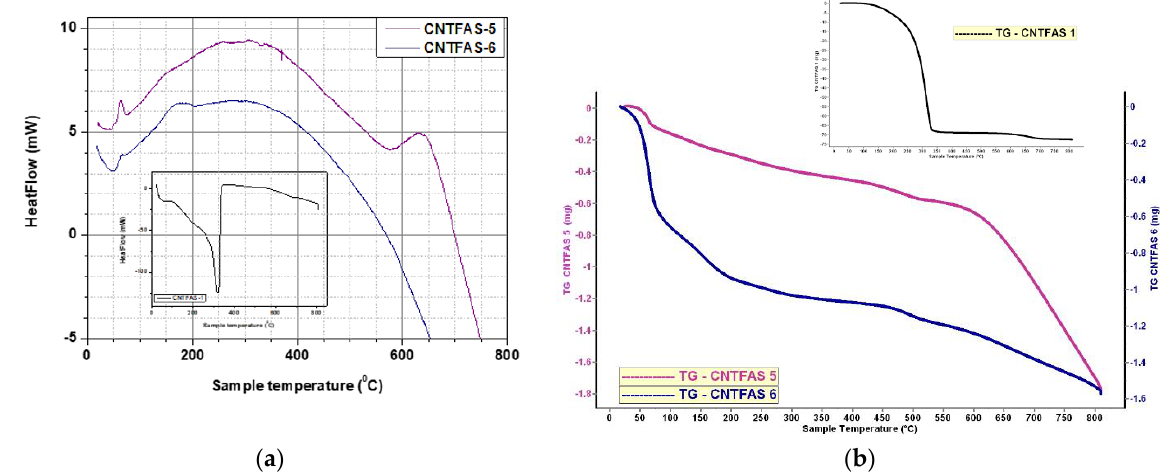
Figure 5. ( a ) DSC-TG curves for: CNTFAS-5 and CNTFAS-6 samples versus CNTFAS-1 sample (inset). ( b ) TG curves for CNTFAS-5 and CNTFAS-6 samples versus CNTFAS-1 sample (inset). Table 3. Thermal effects and mass loss ( ∆ m) in acid-treated CNT